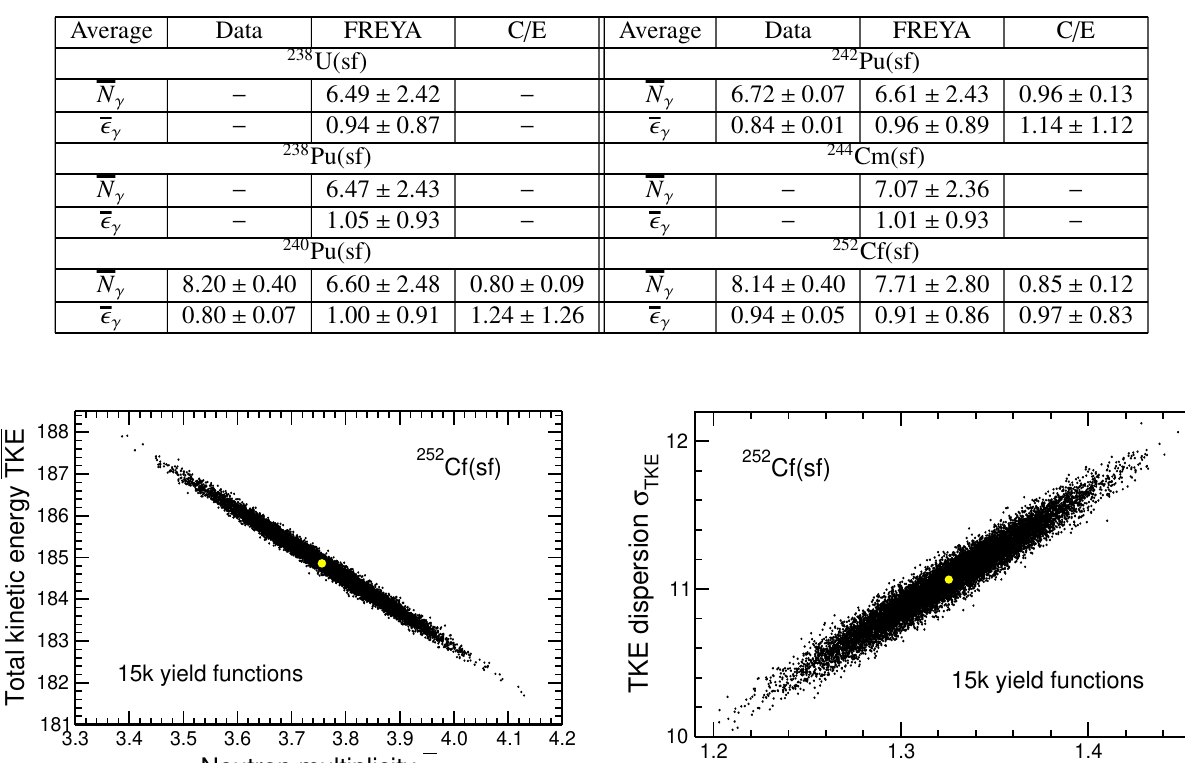
Table 3. The values of the average photon multiplicity N γ and average energy per photon ǫ γ (in MeV) from data (where available), the values calculated with FREYA , and the relevant C / E where applicable. Note that the FREYA uncertainties are not statistical but represent the uncertainties on the parameters. From Ref. [5].